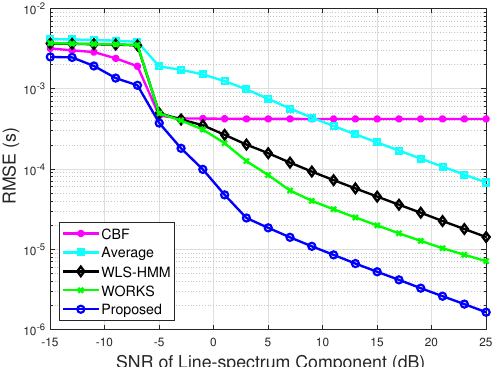
Figure 6. RMSE of time-delay difference estimation versus SNR of the line-spectrum component.